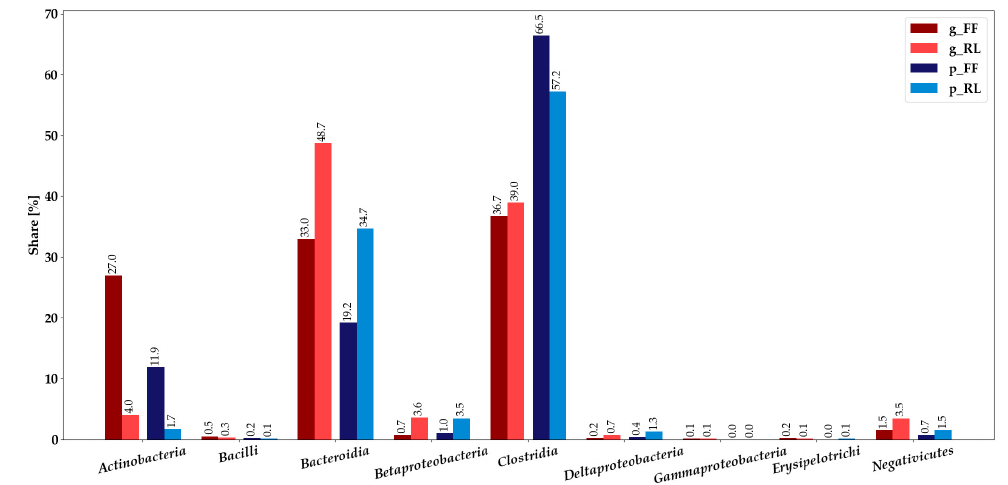
Figure 3. Metaproteomic and metagenomic proportions of identifications at class level (Tables S3, S5 and S6). For the metaproteomics data, proteins that could not be assigned using the bacterial annotations (Table S1) were excluded and made up about 52% and 49% for flash frozen and RNAlater-treated samples, respectively. (g_FF: metagenomic analysis for flash frozen, g_RL: metagenomic analysis for RNAlater, p_FF: metaproteomic analysis for flash frozen, p_RL: metaproteomic analysis for RNAlater).